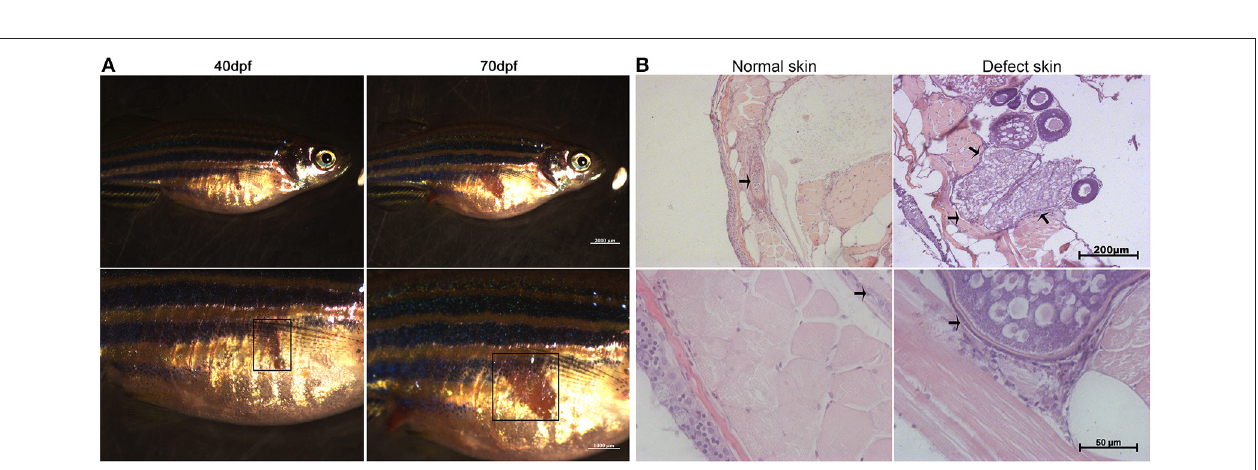
cholesterol fatty acids and triacylglycerols (Blann, 2014).